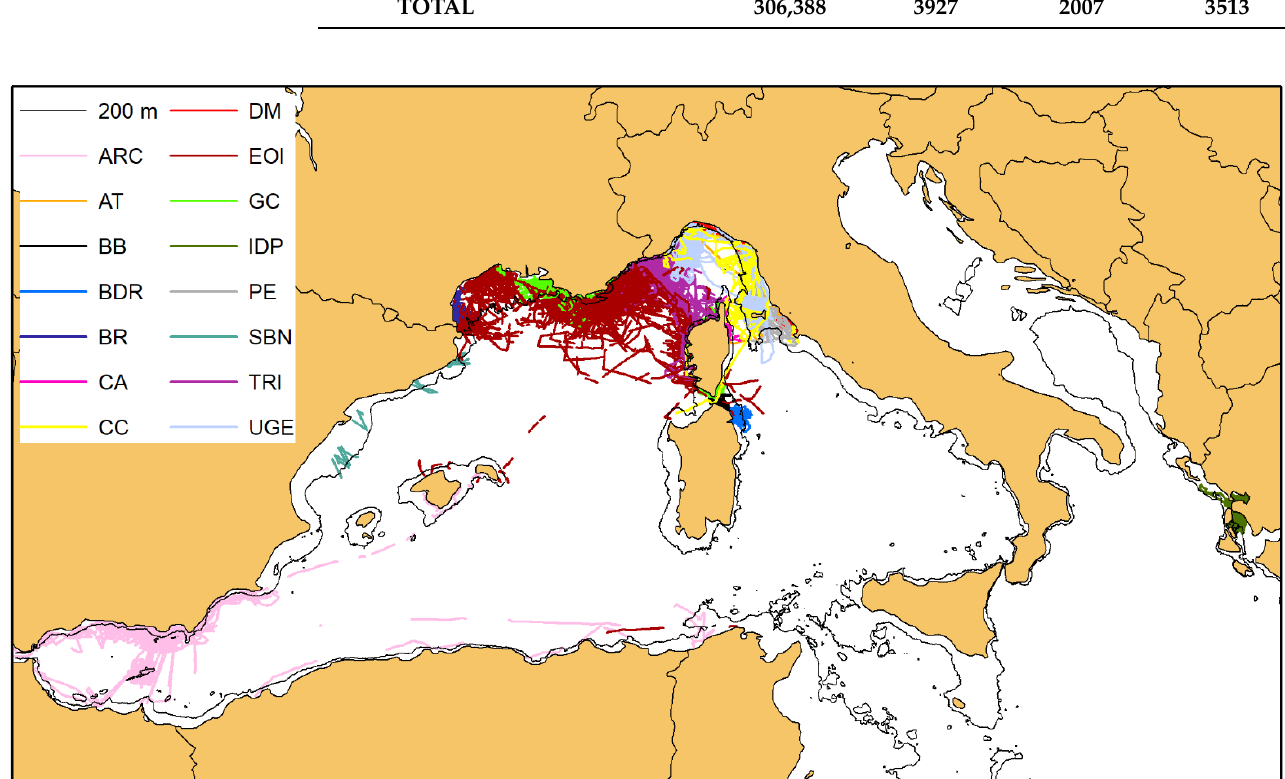
Figure 2. Sampling tracks implemented by each research group involved in the different study areas (see also Tables 1 and 2). The dark line marks border of the continental shelf (200 m isobath) in all the maps.